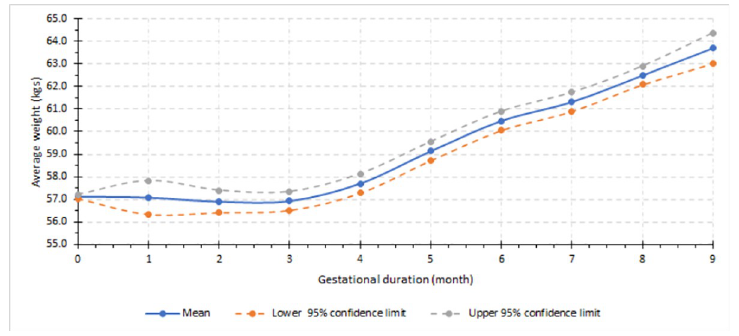
Fig 1. Gestational weight gain trajectories in sub-Saharan Africa.